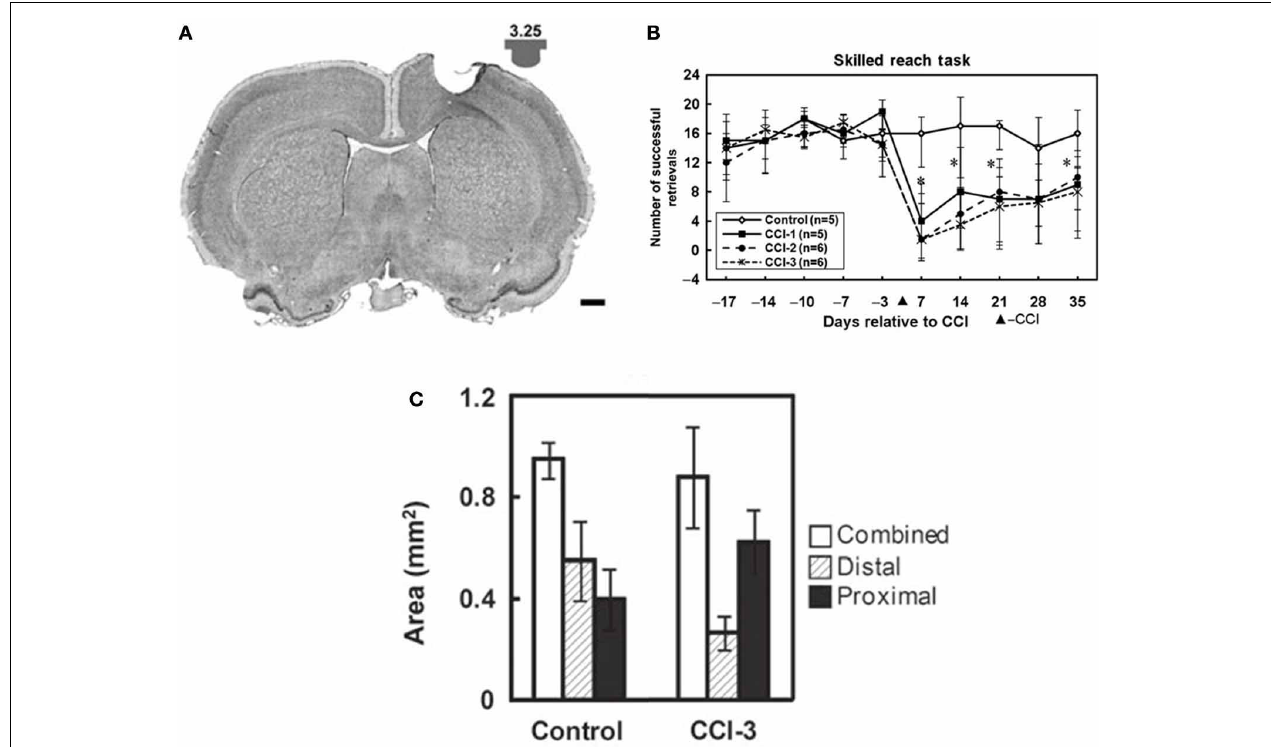
maps in the rat premotor cortex (rostral forelimb area, or RFA) approximately one month after a controlled cortical impact. In the premotor area that was spared by the lesion, digit representations contracted, while proximal representations expanded. This suggests that the behavioral recovery that was observed was due to compensatory kinematic patterns rather than true recovery (Nishibe et al.,